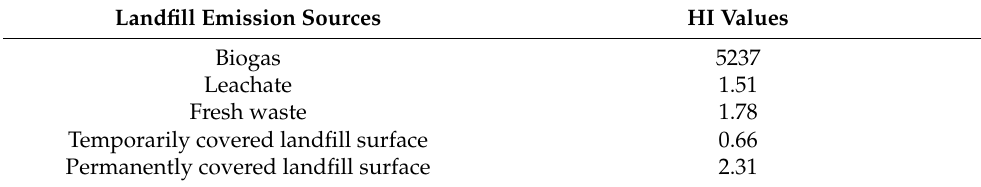
Table 6. Comparison of the HI values obtained for the different landfill odor sources.